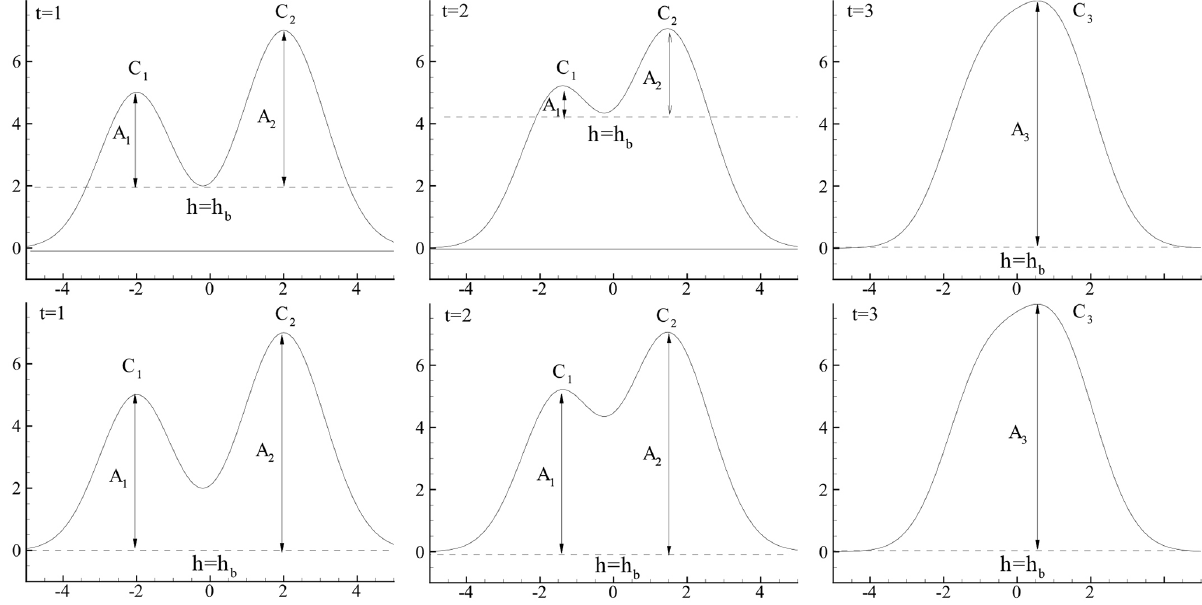
Figure 2. Top panels: time evolution of two merging eddies revealed by the mononuclear eddy identification without segmentation. Bottom panels: time evolution of two merging eddies revealed by the mononuclear eddy identification with segmentation. The h represents the background SLA value, A represents the amplitude of the eddy, and t represents the map at different